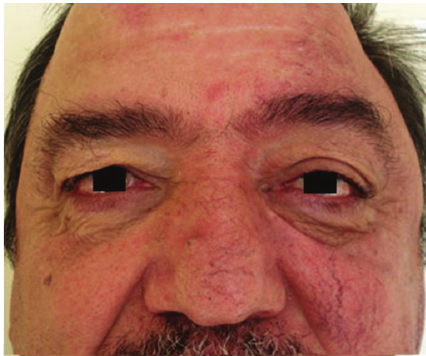
Figure 3: Recovery of the patient after the ligation of fistulas via open approach.